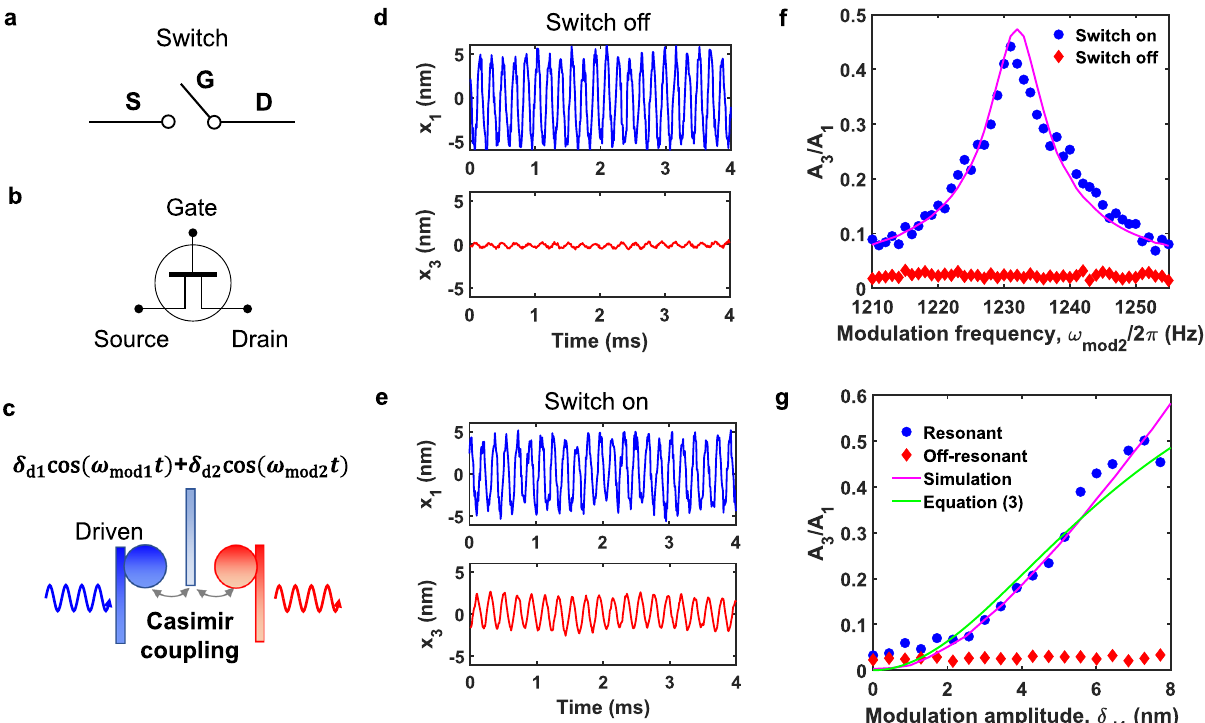
Fig. 3 | Switching quantum- fl uctuation-mediated energy transfer. a A symbolic switch. b A symbolic fi eld effect transistor. c The quantum- fl uctuation-mediated energy transfer between cantilever 1 and 3 can be switched on and off by the modulation on cantilever 2. The position of cantilever 2 is modulated with mod- ulation amplitudes δ d1,2 and modulation frequencies ω mod1,2 . d Measured dis- placement of two cantilevers ( x 1 and x 3 ) when modulation is off. e Measured displacementof twocantileverswhenmodulationison.Energyfromcantilever1is transferred ef fi ciently to cantilever 3. Here ω mod1,2 =2 π ×465Hz, ω mod2 =2 π × 1230Hz, δ d1 =6.0nm, and δ d2 =8.5nm. The separations are d 10 =100nm and